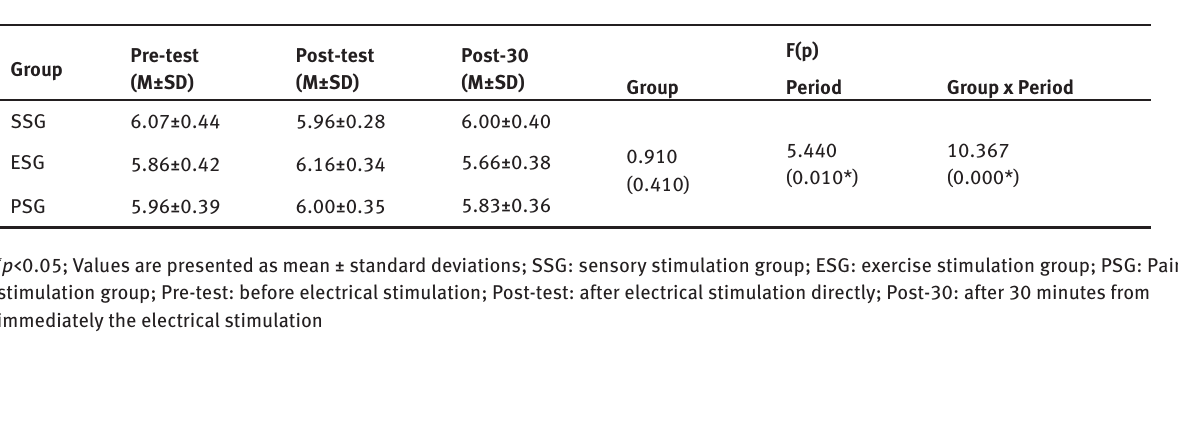
Table 3: The change of vessel size (unit: mm)